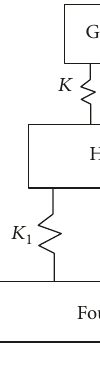
Figure 1: Vibration of gear system.